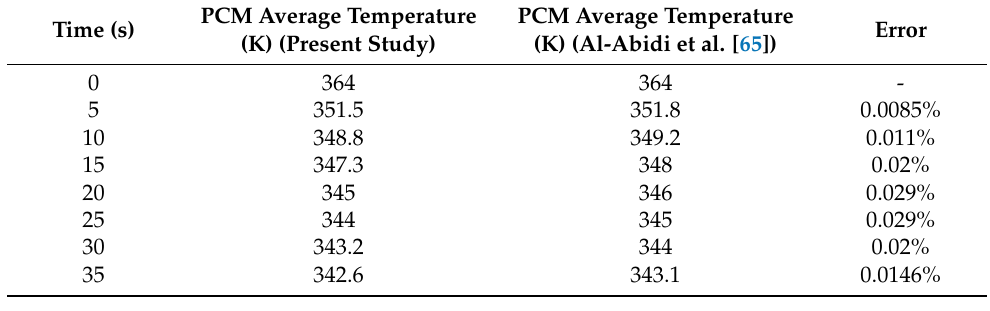
Table 3. The average PCM temperature (K) in both the present study and the work of Al-Abidi et al. [65] with a calculated error.